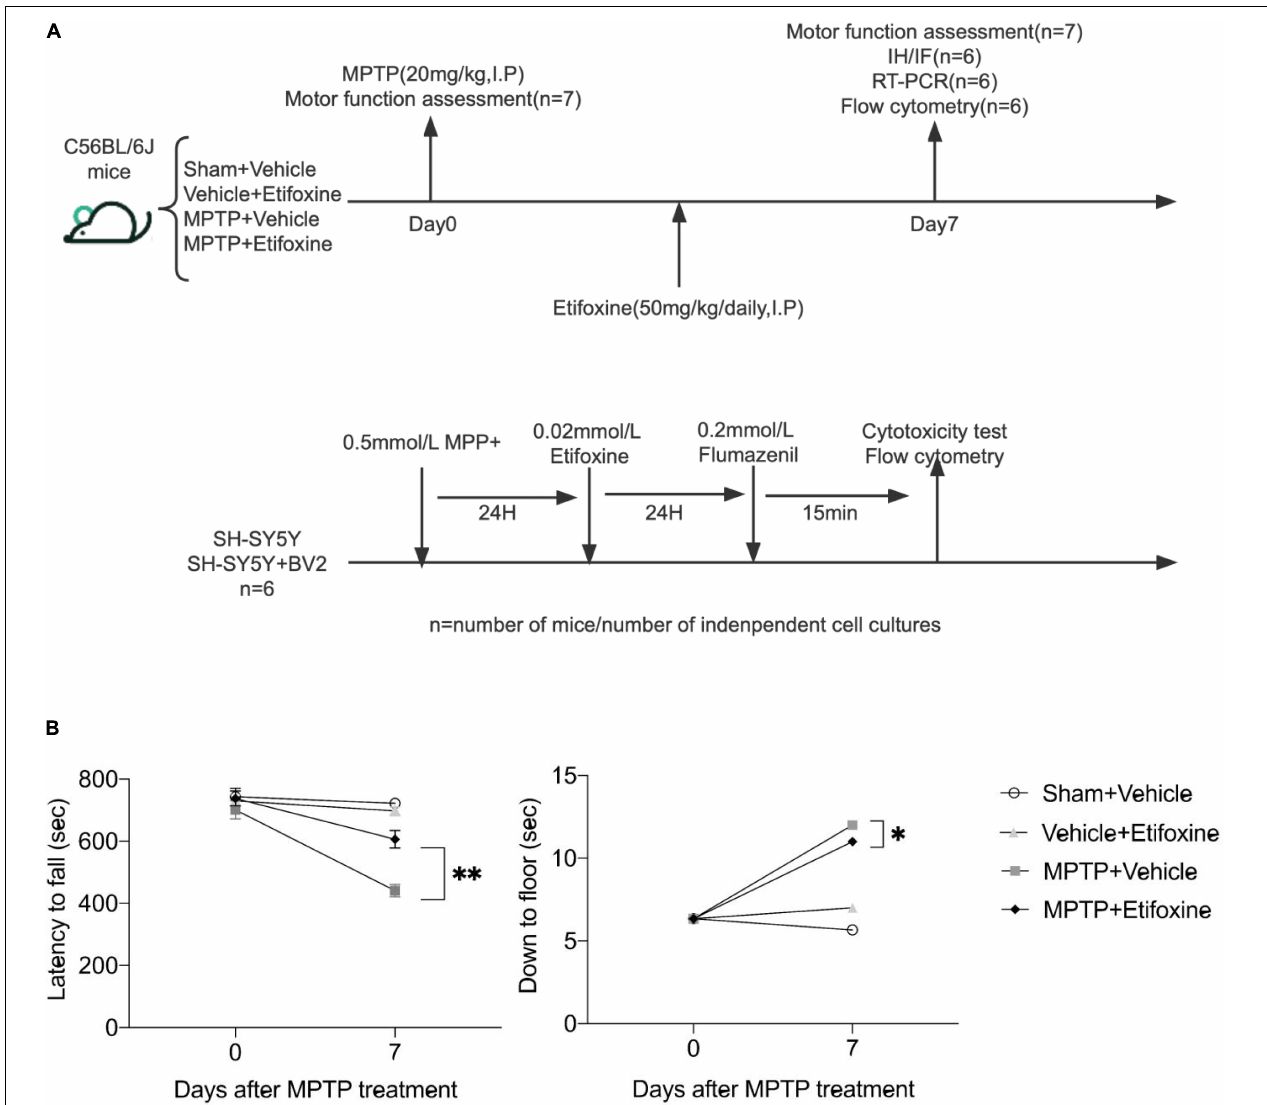
FIGURE 2 | Etifoxine attenuated MPTP-induced motor impairment. (A) Schematic showing the experimental design. C57BL/6 mice were administered etifoxine or vehicle daily until the end of the experiment beginning immediately after saline or MPTP administration (intraperitoneal injection). (B) Effects of etifoxine on the motor function of C57BL/6 mice following MPTP treatment. F (3,48) = 11.86, P < 0.001 (Left); F (3,48) = 35.98, P = 0.024 (Right). Data are presented as means ± SEM. ( n = 7 mice per group), ∗ P < 0.05, ∗∗ P <